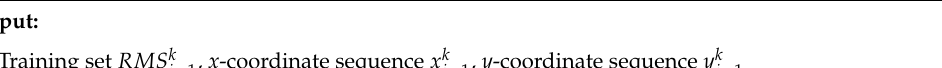
Algorithm 1 KF-GEP Parameters